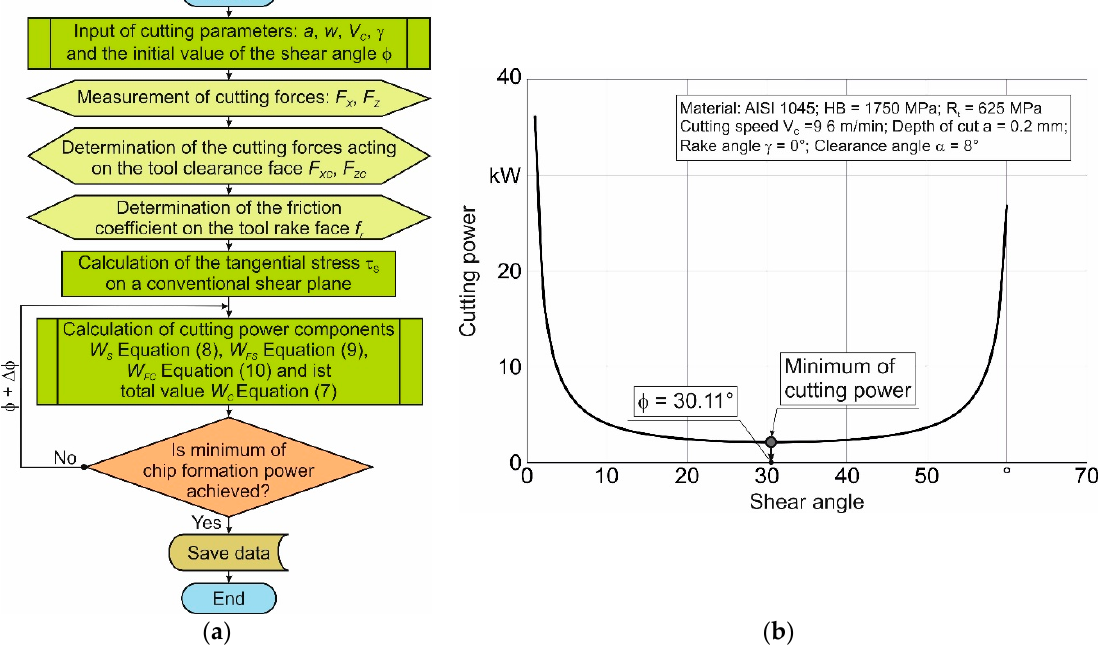
Figure 3. Flowchart for determination of the shear angle ( a ) and cutting power change with a variation of the shear angle ( b ).